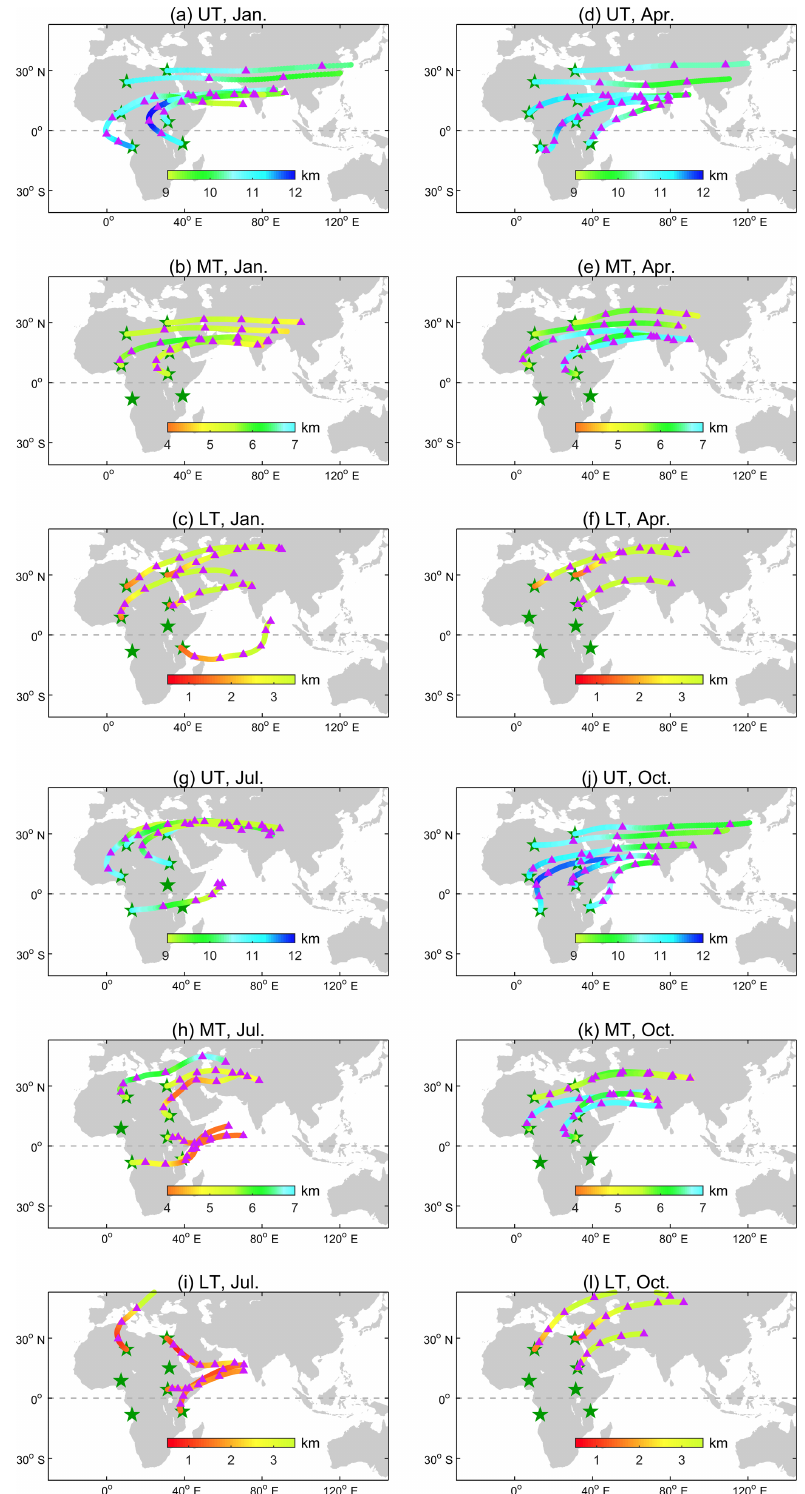
Figure 13. Mean seasonal paths during the period 1987–2006 for the trajectories that reach Asia and start from African sites at Cairo, Ghat, Abuja, Khartoum, Juba, Dar es Salaam, and Luanda (stars; see also Fig. 1) from 11km (UT) (a, d, g, j) , 5.5km (MT) (b, e, h, k) , and 1.5km (LT) (c, f, i, l) in January (a–c) , April (d–f) , July (g–i) , and October (j–l) . The triangles along the trajectory paths indicate the lapse days from the